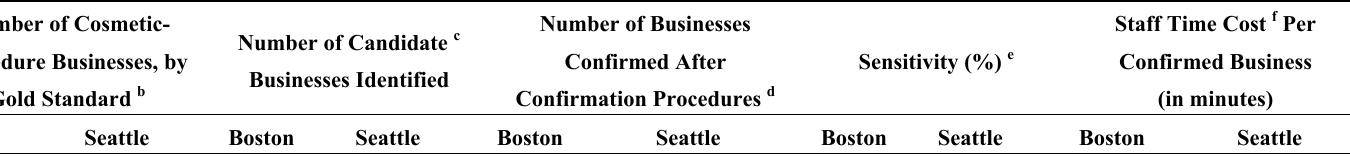
Table 4. Small-areas validation: Cosmetic-procedure business identification and confirmation, sensitivity, and staff time cost by business density comparing various validation methods in Boston and Seattle, 2011–2012 a